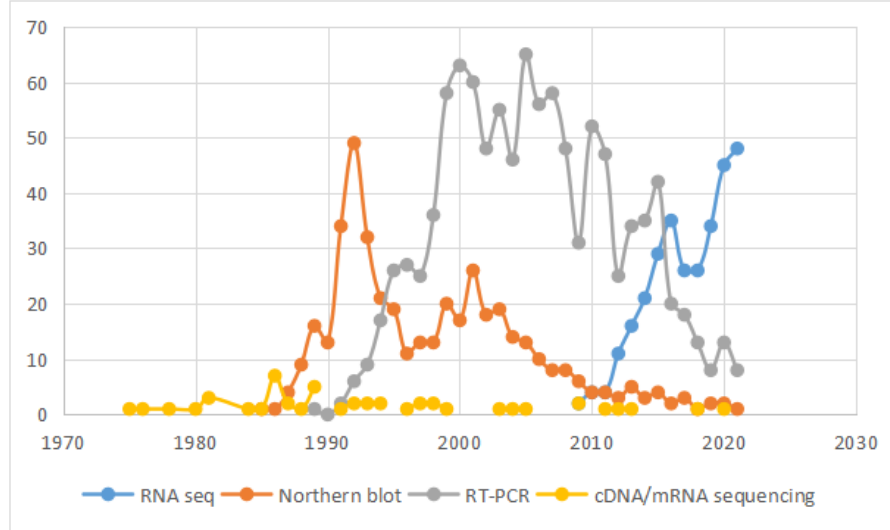
Figure 2. The number of articles using cDNA/mRNA sequencing, Northern blot, RT-PCR and RNA-seq for chimeric RNA detection.